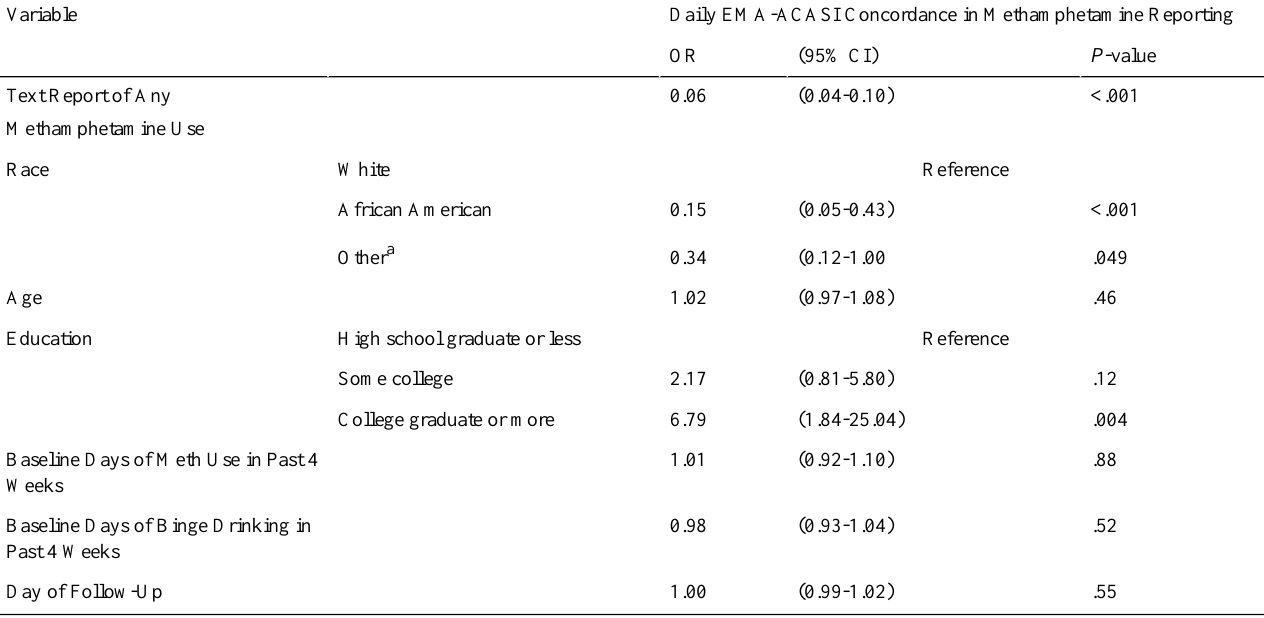
Table 3. Multivariable logistic regression model, fit with generalized estimating equations, assessing daily EMA-ACASI concordance in methamphetamine reporting (n=994).